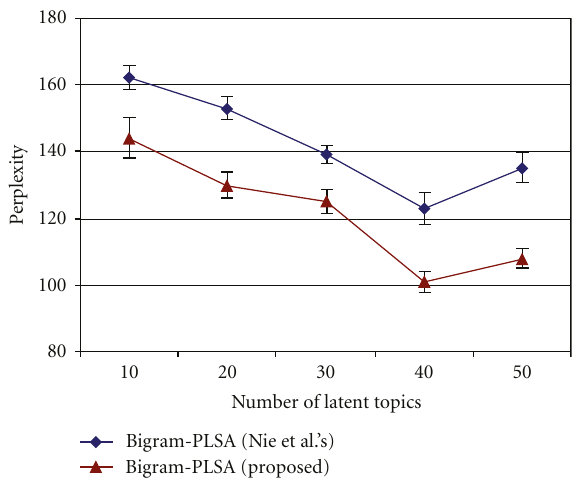
Figure 1: The average perplexities obtained by the proposed and Nie et al.’s bigram-PLSA model with respect to di ff erent numbers of latent topics.